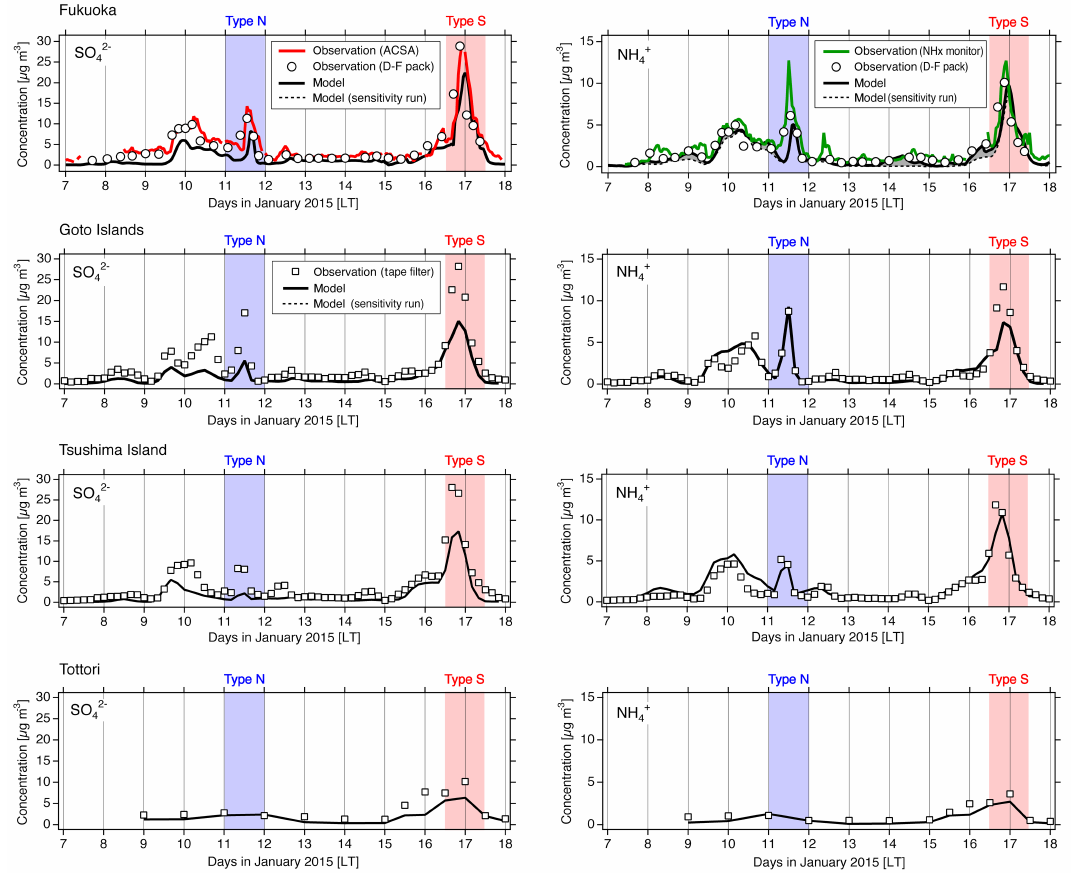
Figure 5. The temporal variation in SO 2 − and NH + over Japan at Fukuoka, the Goto Islands, Tsushima Island, and Tottori from 7–17 Jan- 4 4 uary 2015. The blue and red shading shows the type N and S patterns focused on in this study. The red lines indicate SO 2 − by ACSA, and the green lines indicate NH + observations by the NH x monitor at Fukuoka. The open circles are D–F pack observations 4 at Fukuoka. The open squares are tape filter measurements at the Goto Islands, Tsushima Island, and Tottori. The black lines indicate the base case simulation, and the dotted black lines indicate the sensitivity simulation in which the anthropogenic emissions from Japan were switched off; the differences between these results, shown in gray, represent local